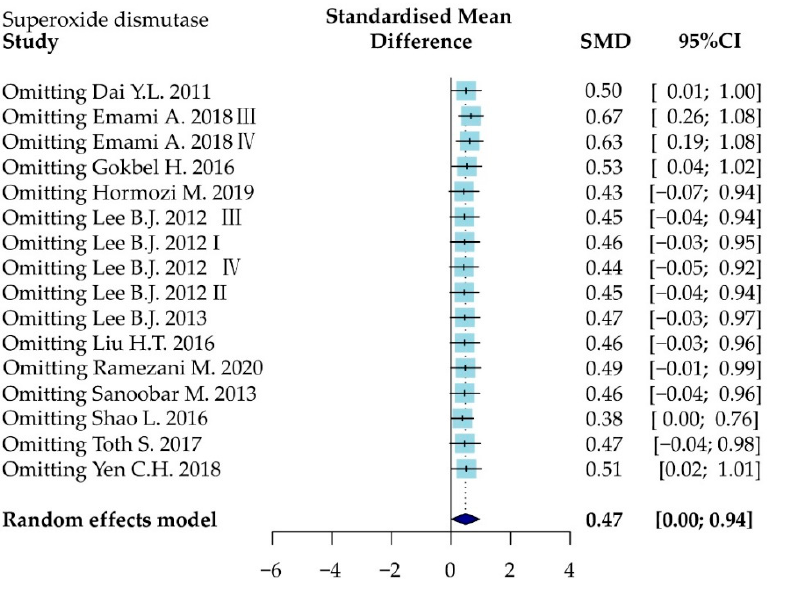
Figure A4. Sensitivity analysis for the effects of CoQ10 on SOD through removal of individual trials one by one. Table A1. Search strategy. For all databases, searches were performed for the time period until 30 March 2022.